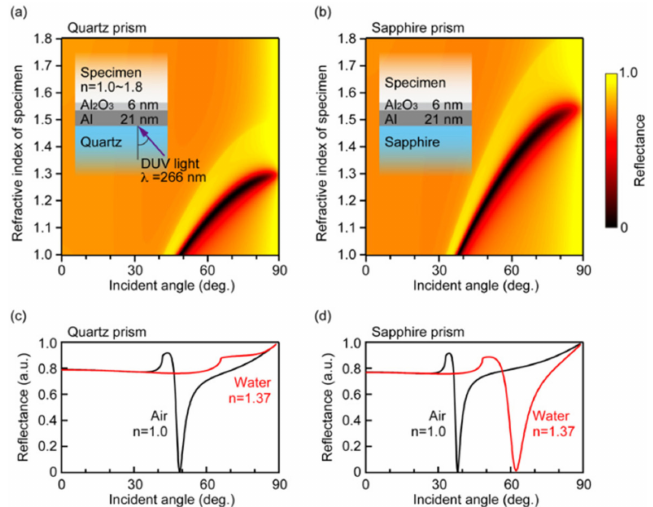
Figure 2. The theoretical reflectance dependence on the incident angle and the refractive index of specimen for aluminum thin film on ( a ) quartz and ( b ) sapphire prisms and the line profiles in refractive indices of air and water on ( c ) quartz and ( d ) sapphire